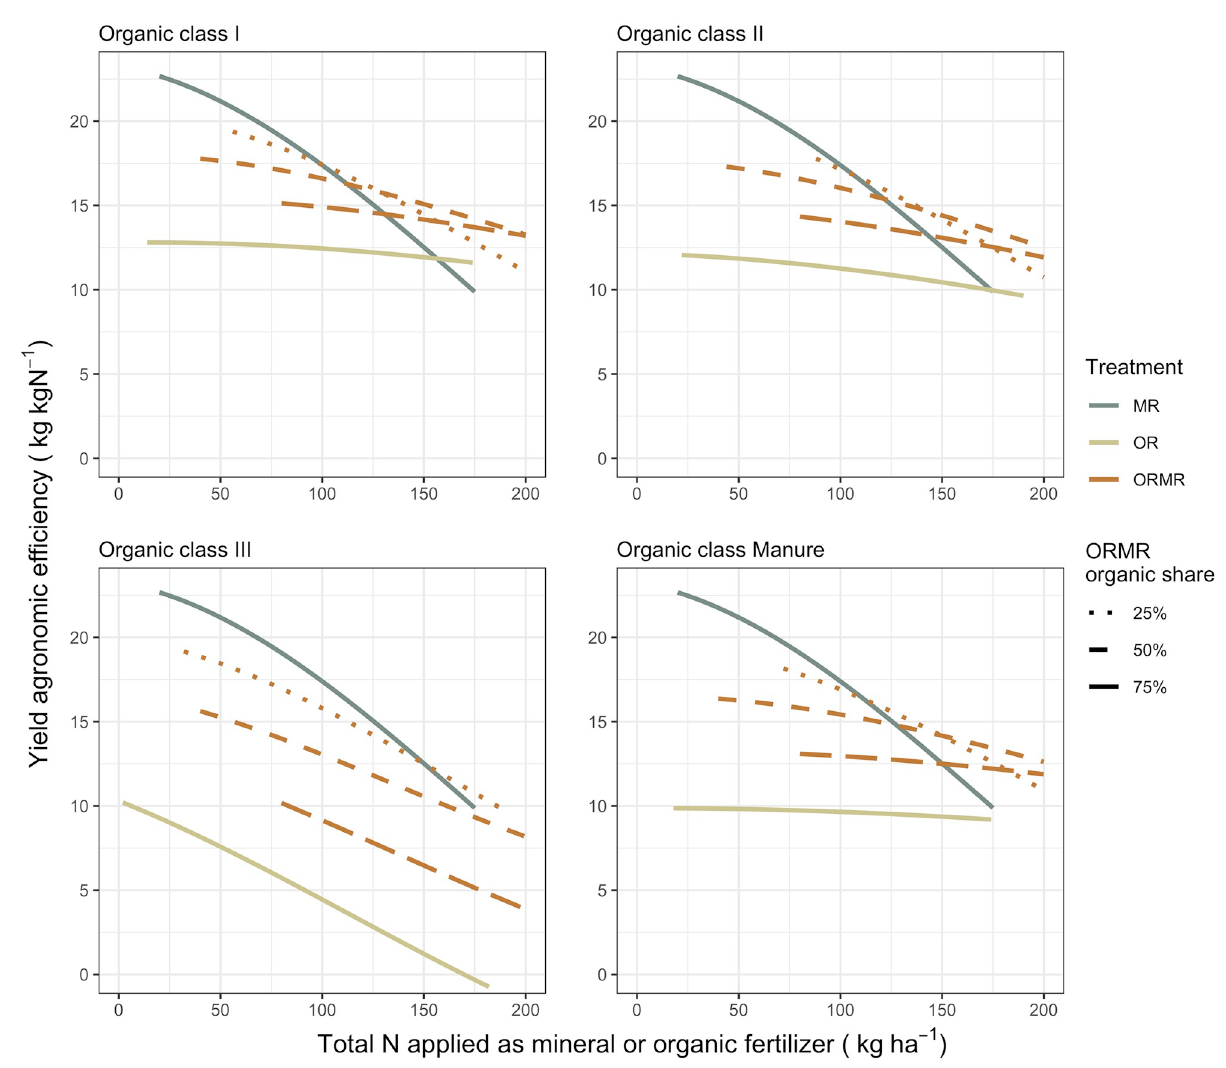
Fig 7. The agronomic efficiency (AE, in kg kgN -1 ) was plotted for the available total N rate, within a range of 0-200 (kg ha -1 ), applied as mineral or organic fertilizer, separately for each organic class and for ORMR with three different organic N input proportions.